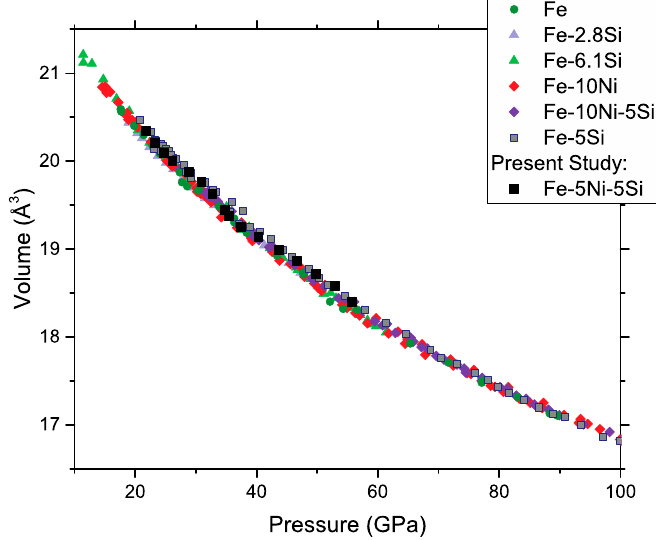
Figure 2. Isothermal compression curve of hexagonal close-packed (hcp) Fe–5Ni–5Si at ambient temperature compared to those of Fe [4] and Fe–Si alloys with 2.8 [21], 5 [23] and 6.1 wt% Si [21], an Fe–Ni alloy with 10 wt% Ni [8] and an Fe–Ni–Si alloy with 10 wt% Ni and 5 wt% Si [8], all in the hcp structure.